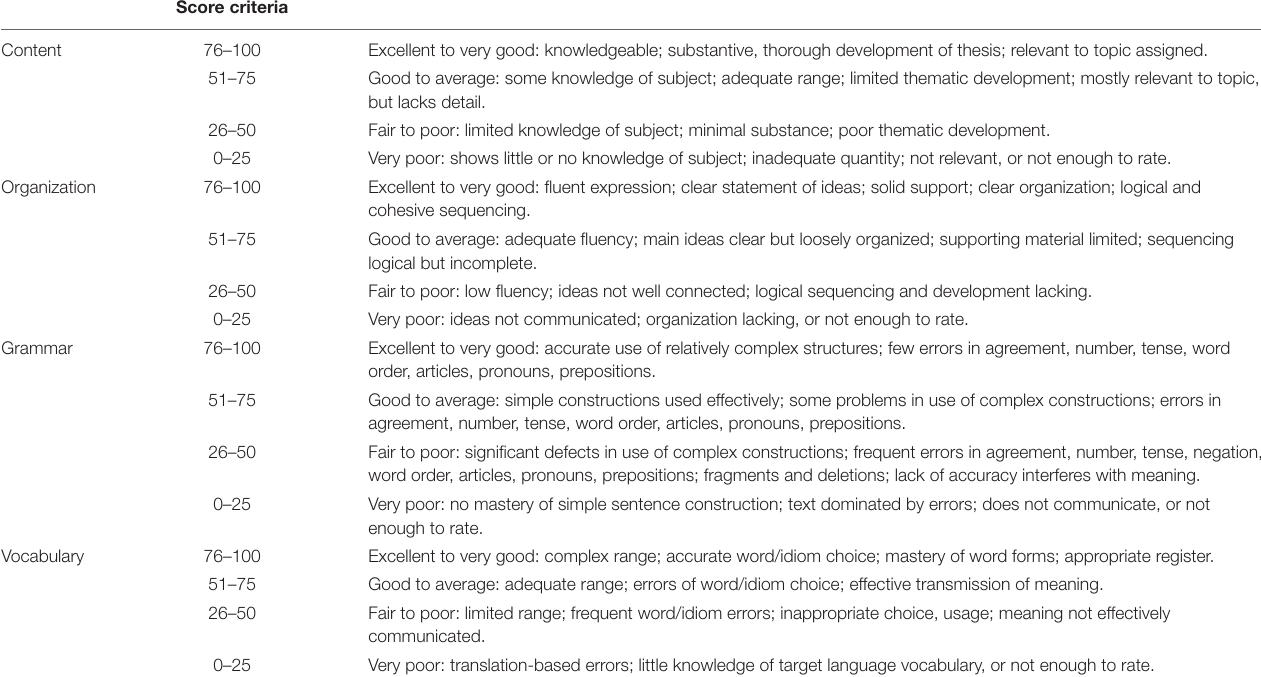
TABLE A1 | Modified argumentation rating rubric of Hedgcock and Lefkowitz (1992).